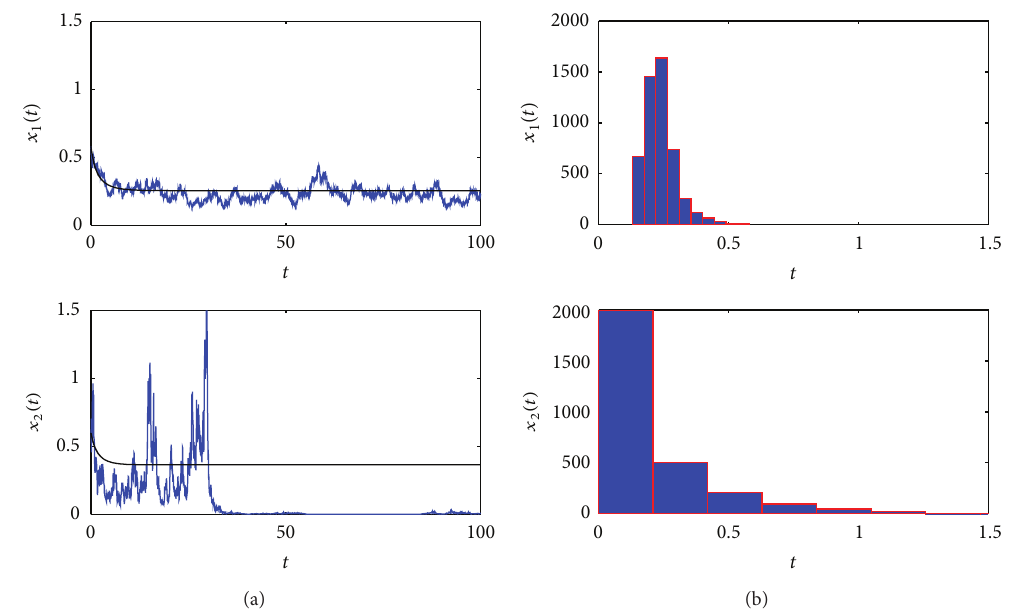
Figure 5: The subgraphs are defined as in Figure 4. Because there is no diffusion, 𝑥 2 is isolated and will die out; 𝜎 1 = 0.2 , 𝜎 2 = 0.8 ; 𝑑 12 = 0.01 , = 0 . 𝑑 21